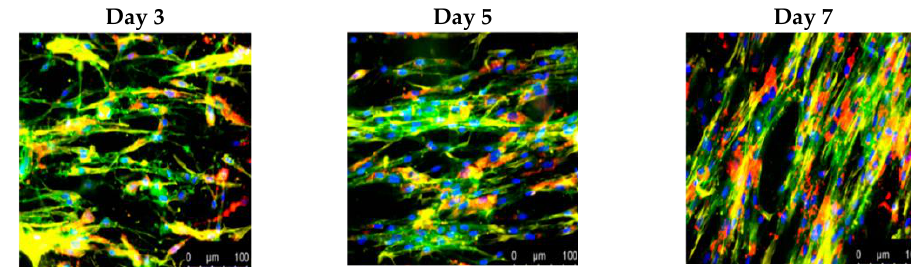
Figure 17. Fluorescent images of VICs in middle layer. Adapted with permission from ref. [231]. Copyright 2018 MDPI.